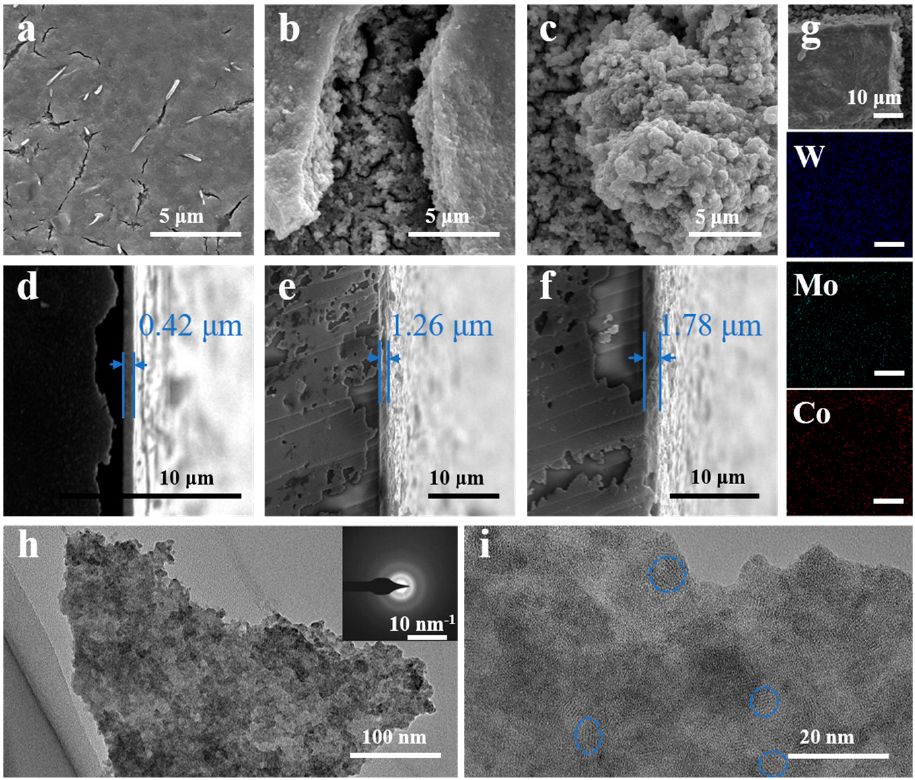
Figure 2. Scanning electron micrographs of WO 3 : Co, Mo films prepared with different electrodeposition time: ( a ) 60 s; ( b ) 180 s; ( c ) 300 s. Cross-sectional SEM images of WO 3 : Co, Mo films prepared with different electrodeposition time: ( d ) 60 s; ( e ) 180 s; ( f ) 300 s. ( g ) SEM-EDS spectrum of WO 3 : Co, Mo film prepared by electrodeposition for 180 s. ( h ) Transmission electron micrograph of WO 3 : Co, Mo film prepared by electrodeposition for 180 s and its 20 nanometer scale ( i ). The inset displays the SAED pattern with a 10 nm − 1 scale bar.